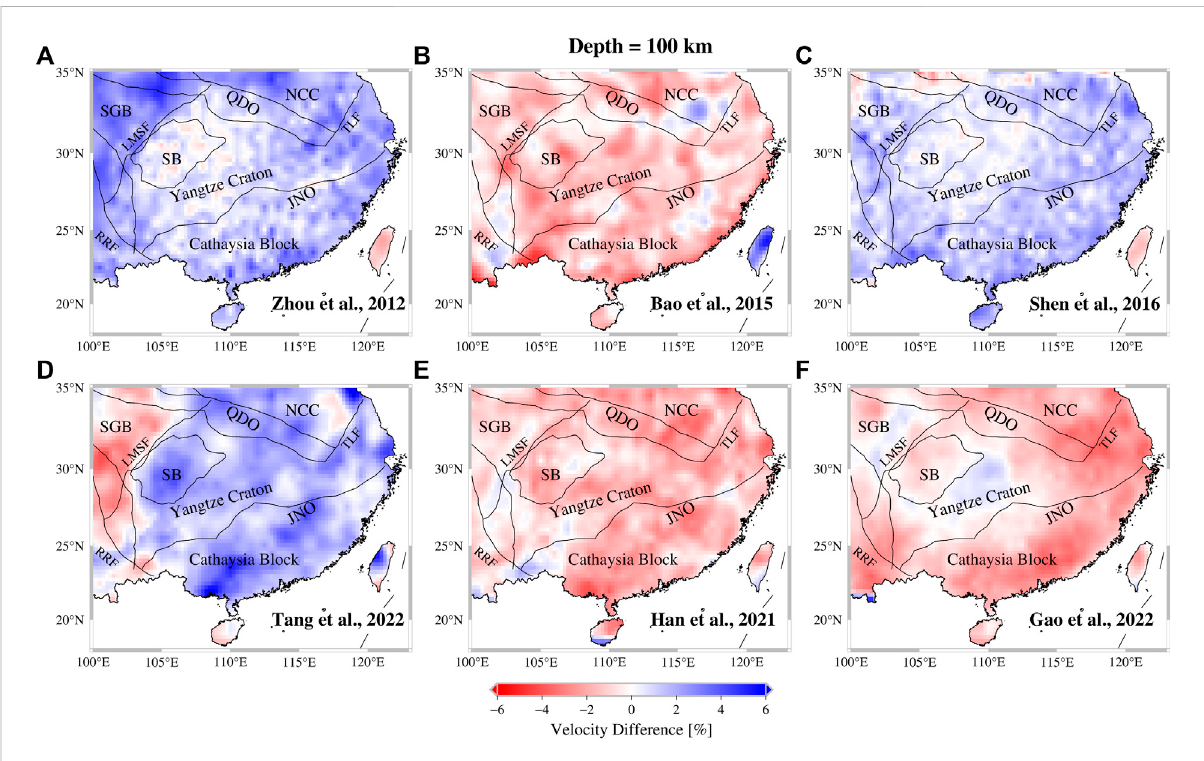
FIGURE 6 Horizontal slices at 100 km depth through SV wave velocity showing the relative velocity difference between regional models of (A) Zhou et al. (2012) (B) Baoetal.(2015) (C) Shenetal.(2016) (D) Tangetal.(2022) (E) Hanetal.(2021) (F) Gaoetal.(2022)andthemantlecomponentofSREM-SC,